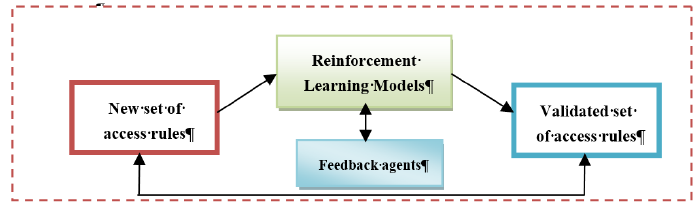
Fig. 3. Inputs and Outputs of Reinforcement Learning